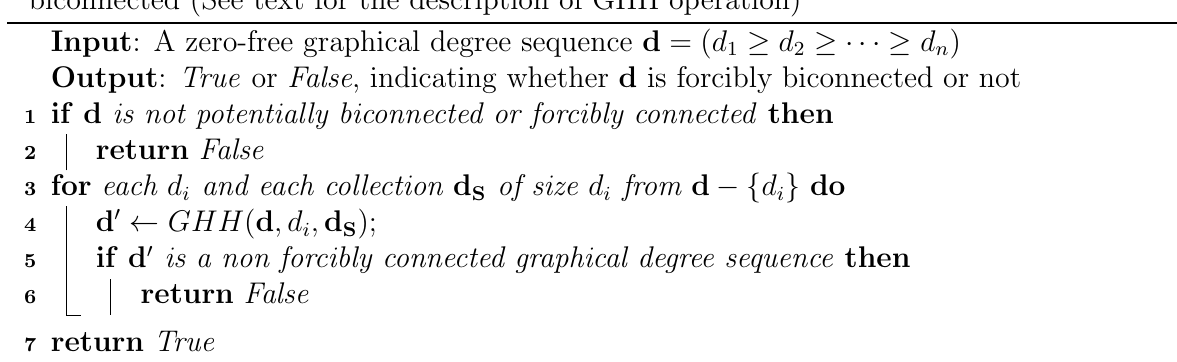
Algorithm 2: Pseudo-code to test whether a graphical degree sequence is forcibly biconnected (See text for the description of GHH